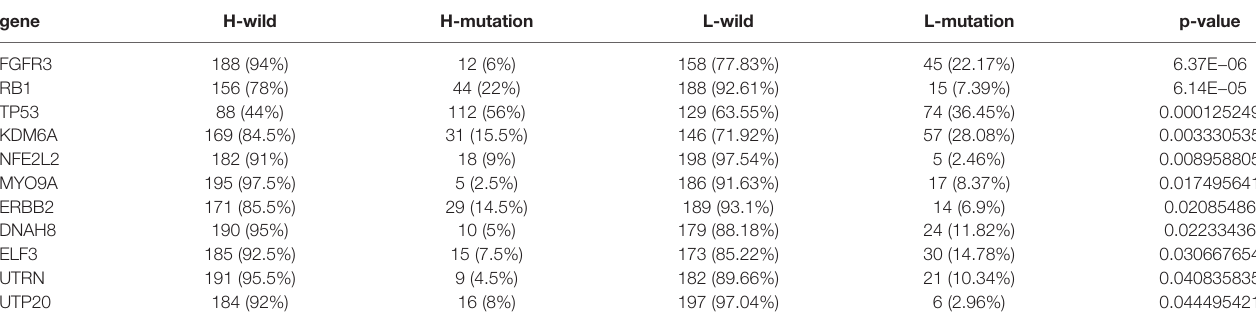
TABLE 2 | Mutant genes between high and low SUMO score